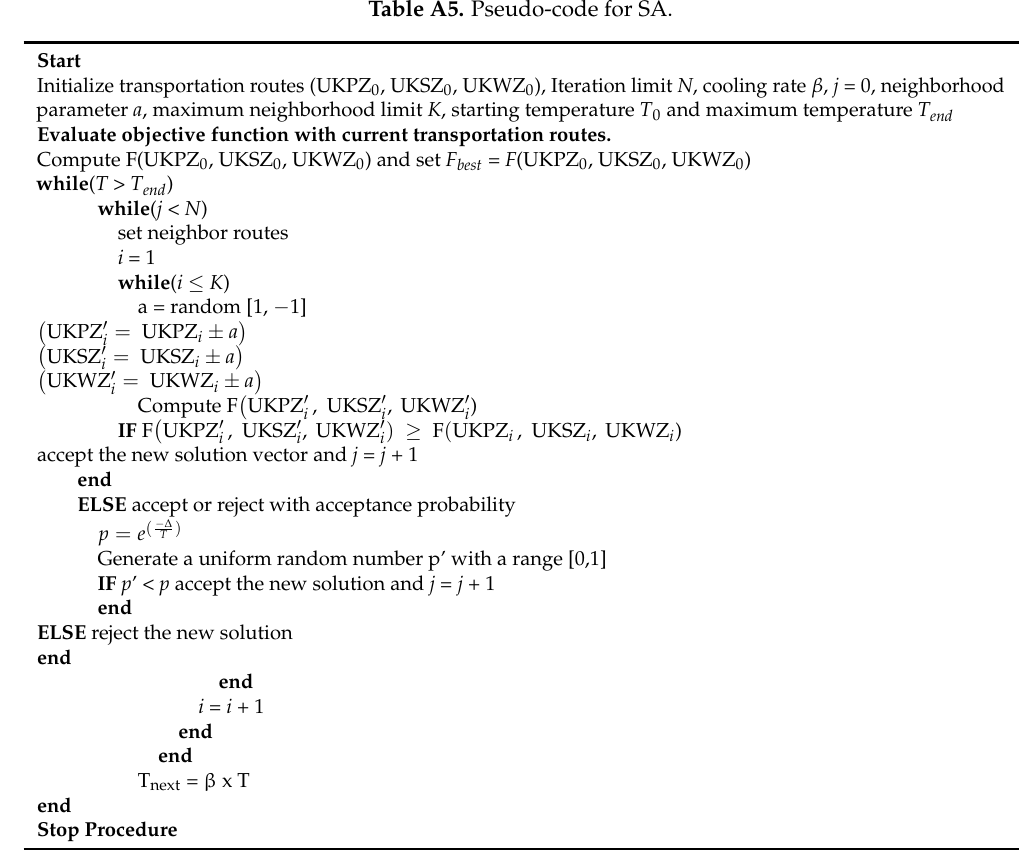
Table A5. Pseudo-code for